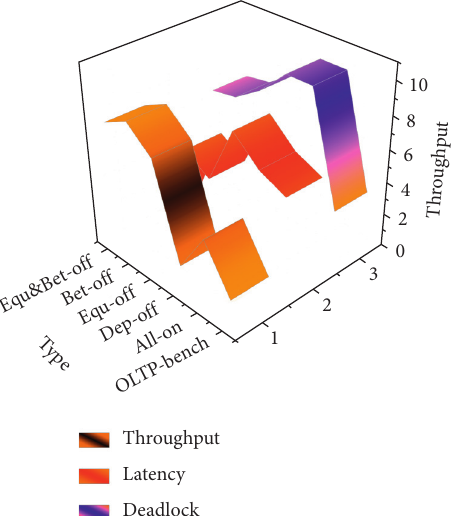
Figure 5: Impact on transaction conflict strength, deadlock like- lihood, and scan data